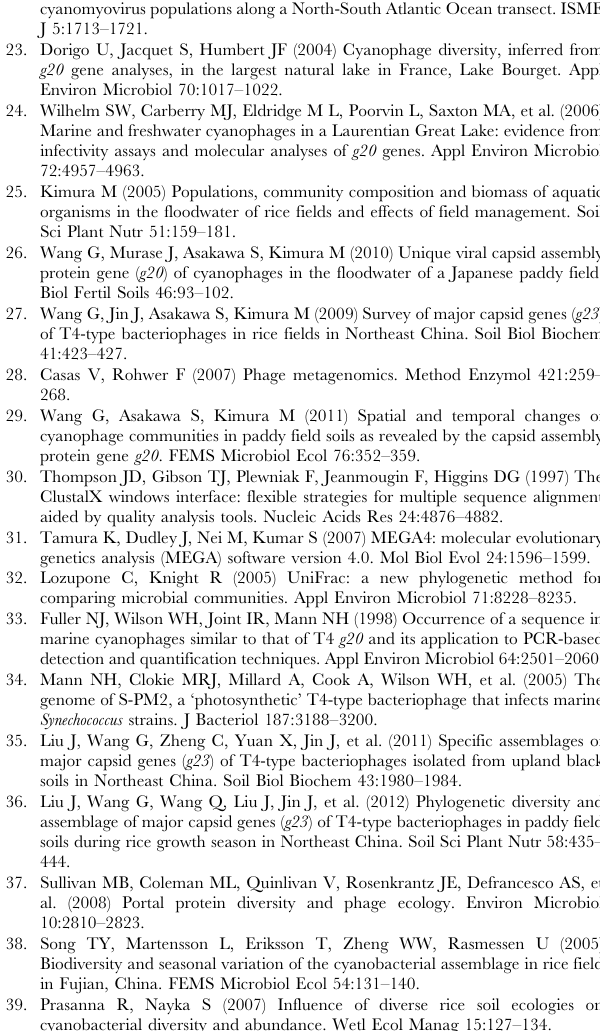
Table S2 P -value test for comparing each point in paddy floodwater in NE China to each point for paddy floodwater and soil in Japan based on UniFrac analysis. Table S3 P -value test comparing each point in paddy floodwater to each point for other environments based on UniFrac